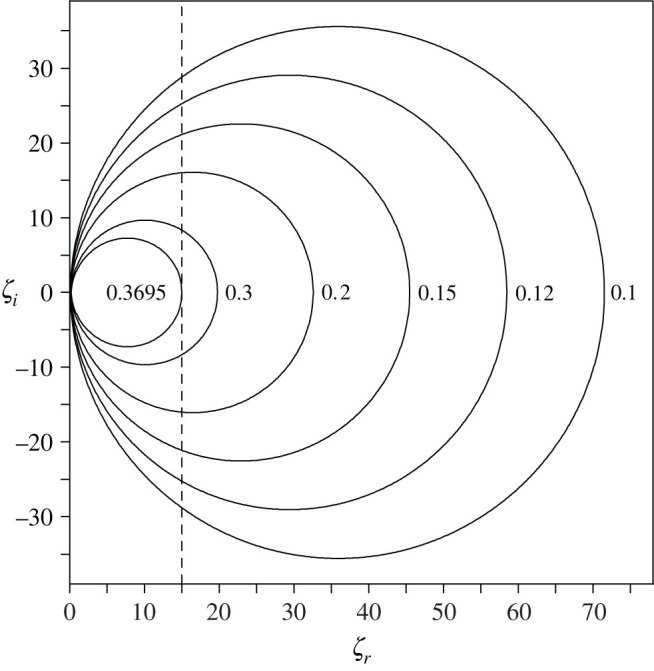
Contours of constant values of the absorption coefficient α in complex ζ-plane.